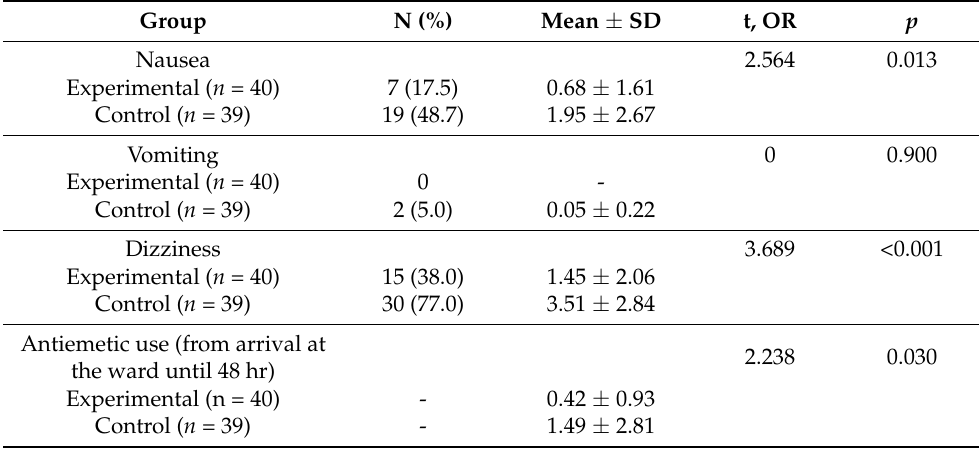
Table 3. Comparison of levels of postoperative nausea, vomiting, dizziness and the frequency of antiemetic use after education ( n = 79). Group N (%) Mean ± SD t, OR p Nausea